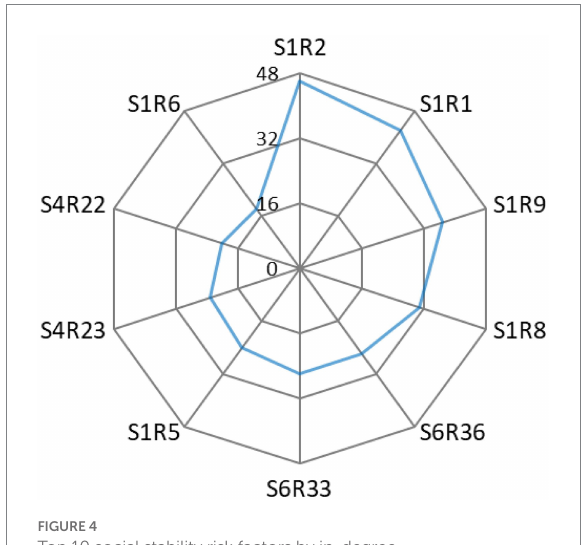
FIGURE 4 Top 10 social stability risk factors by in-degree.